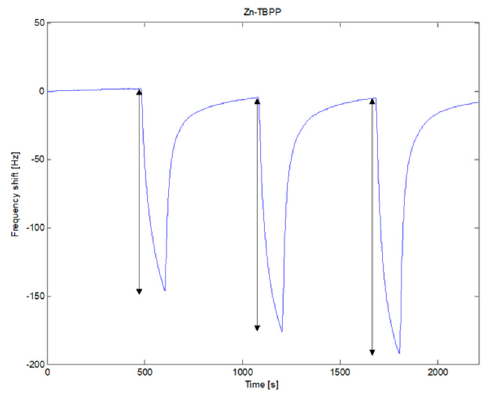
Figure 3. Signal recorded by the Zn-TBPP sensor. It shows the sensor behavior for the sequence of exposures to the headspace of A. niger , A. flavus and A. fumigatus in order. Arrows indicates the frequency shift considered as the sensor response and used in the data analysis. The response time is 135 s.